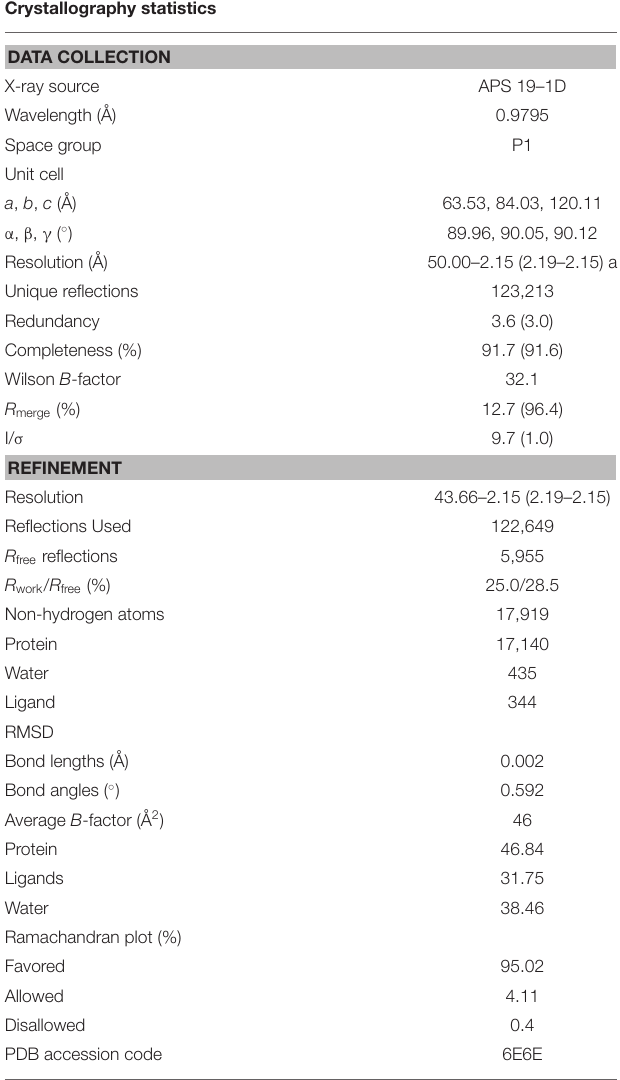
TABLE 1 | Data collection and refinement